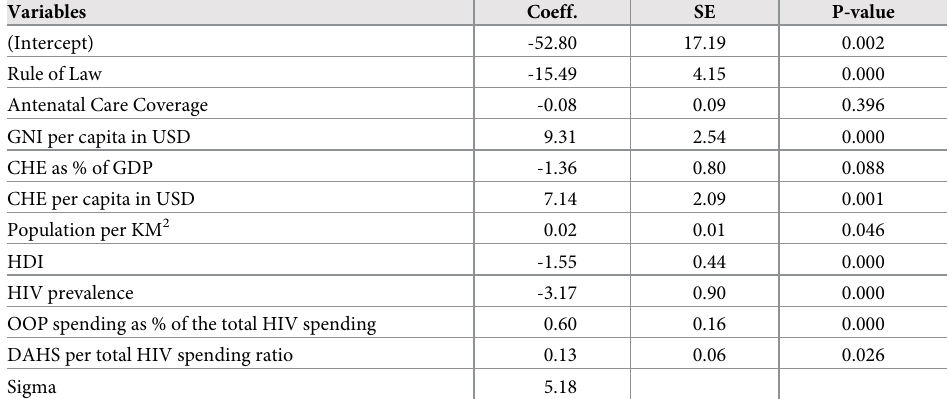
Table 4. Results of the robust coefficients in the truncated regression for the reciprocal of the efficiency scores (i.e. inefficiency) (N = 78). Variables Coeff. SE P-value (Intercept) -52.80 Antenatal Care Coverage